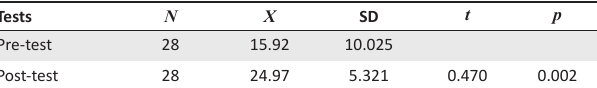
TABLE 3: The t -test comparison of the experimental group’s Brief Infant-Toddler Social and Emotional Assessment pre- and post-test scores.